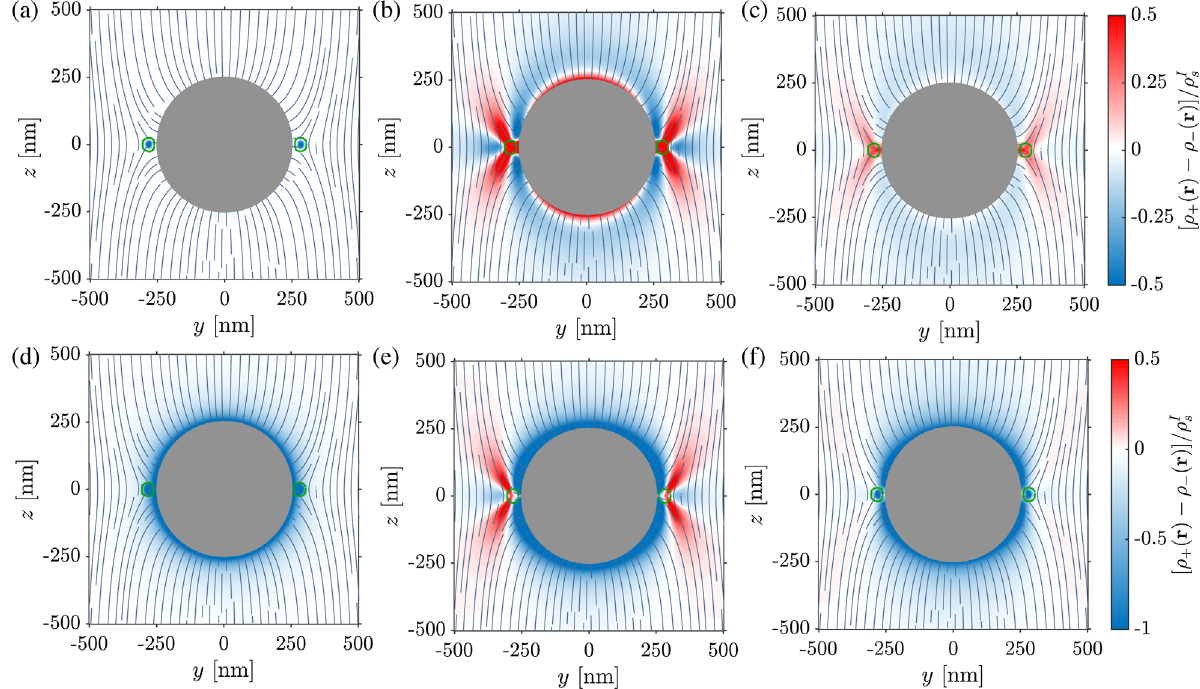
FIG. 9. Net ion-charge distributions ½ ρ ð r Þ − ρ − ð r Þ(cid:3) = ρ I s around a Saturn-ring defect formed around a colloidal sphere of radius þ a ¼ 250 nm with strong homeotropic boundary conditions. The streamlines indicate the nematic-director pattern. In panels (a) – (c), σ ¼ 0 . 001 q nm − 2 . We the particle is uncharged, while in panels (d) – (f), the particle has a constant-surface charge density q e e distinguish cases with (a,d) only ion partitioning ( g ¼ 3 , g − ¼ 8 , G ¼ 0 ), (b,e) only flexoelectricity ( g ¼ 0 , q e G ¼ 10 pC m − 1 ), þ (cid:1) and (c,f) both effects ( g ¼ 3 , g − ¼ 8 , q e G ¼ 10 pC m − 1 ). In all plots, we use κ − 1 ¼ 25 nm, which results in an isotropic bulk ion þ I 1 . 8 × 10 − 5 density ρ I s ¼